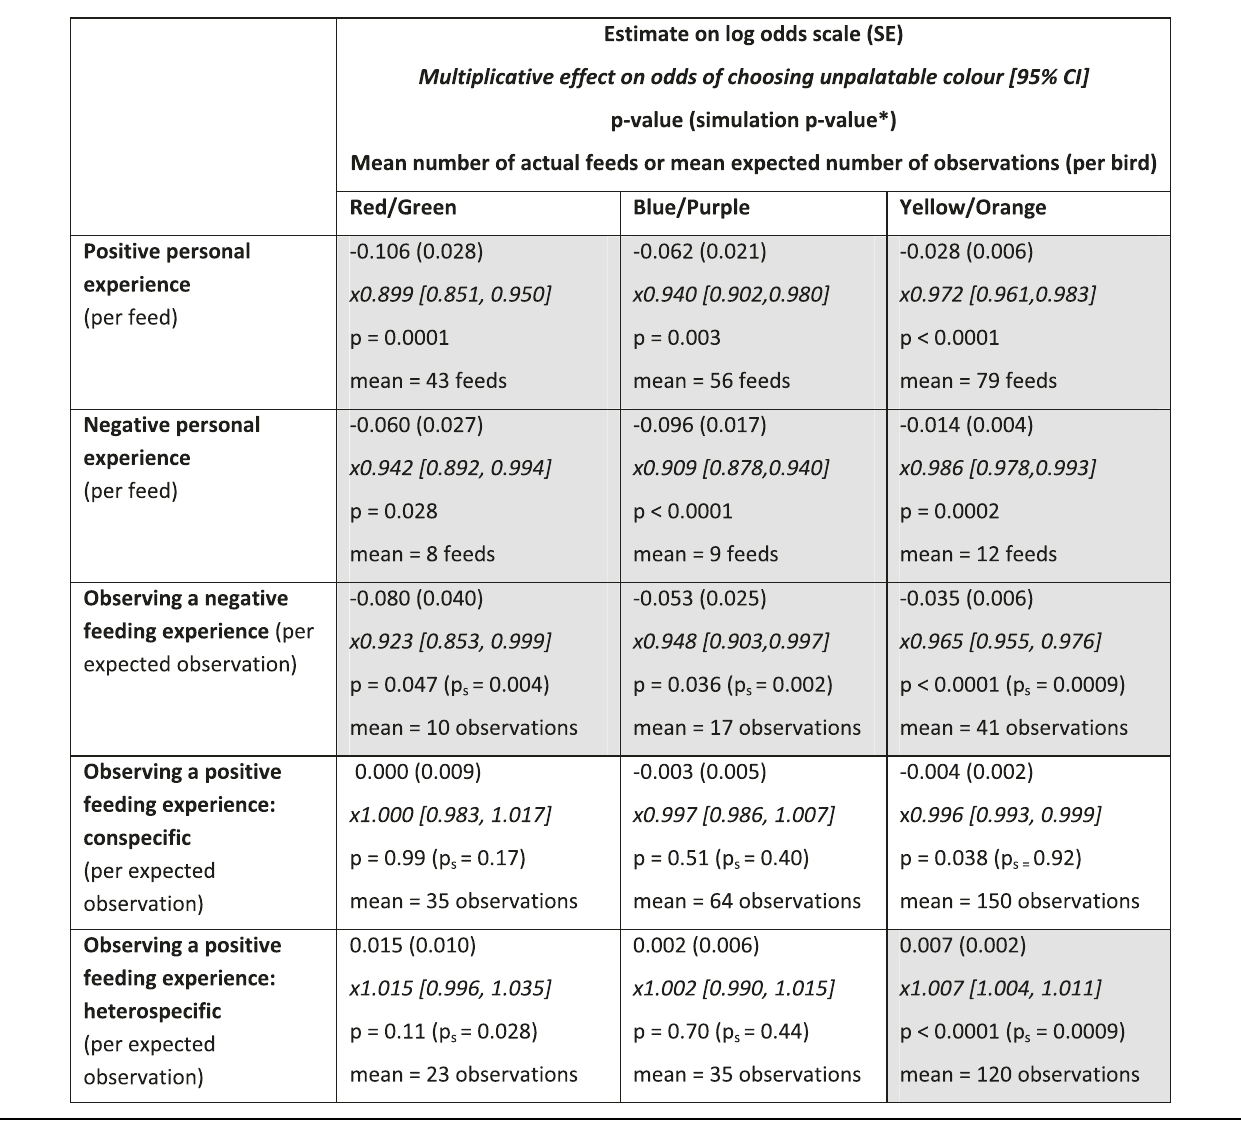
Table 1 Summary of the asocial and social effects in three avoidance learning